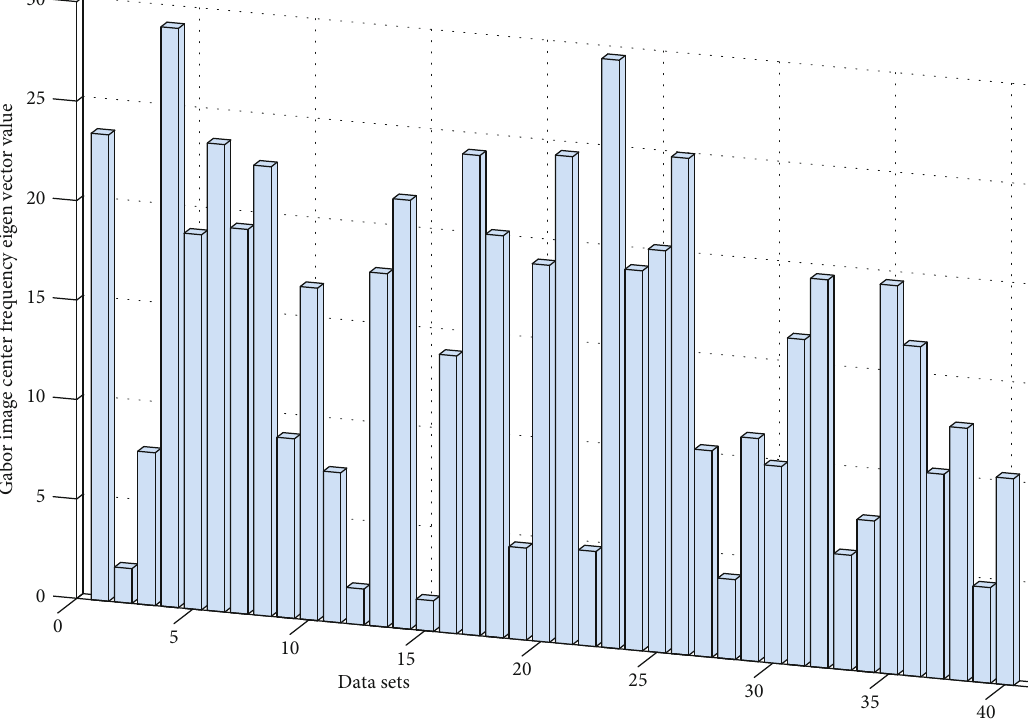
Figure 5: The histogram of the eigenvector value of the center frequency of the Gabor